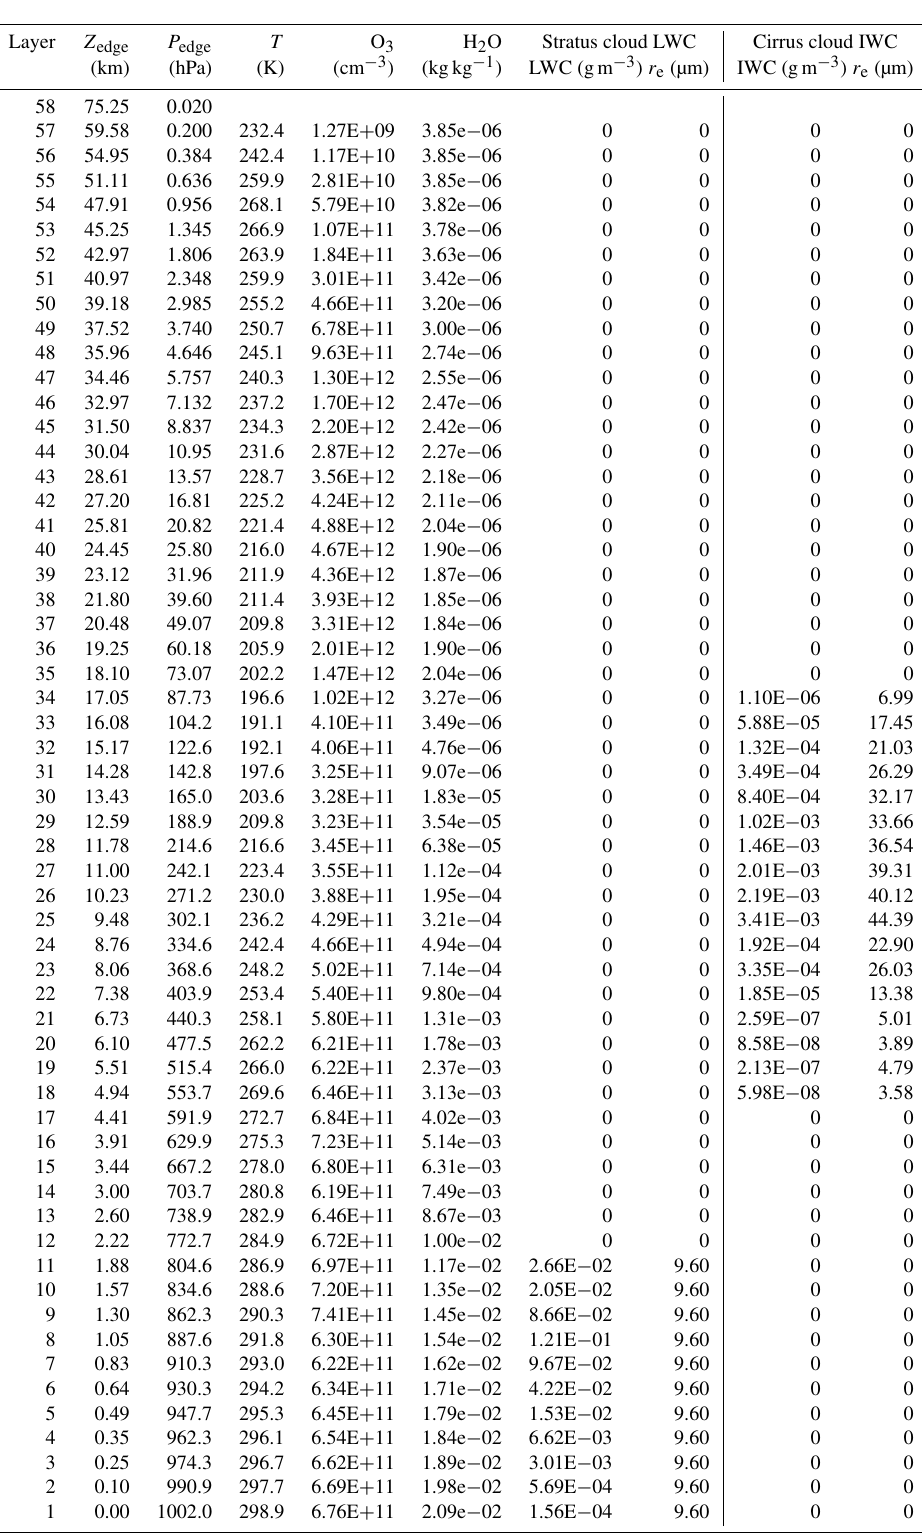
Table 3. The standard tropical atmosphere and the two cloud profiles implemented in both Solar-J and RRTMG-SW. Height ( Z ) and pressure ( P ) are edge values; others are layer